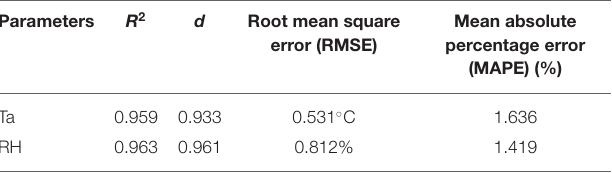
TABLE 3 | Quantitative measurement of ENVI-met model performance based on simulated and measured values of meteorological elements in Chigang